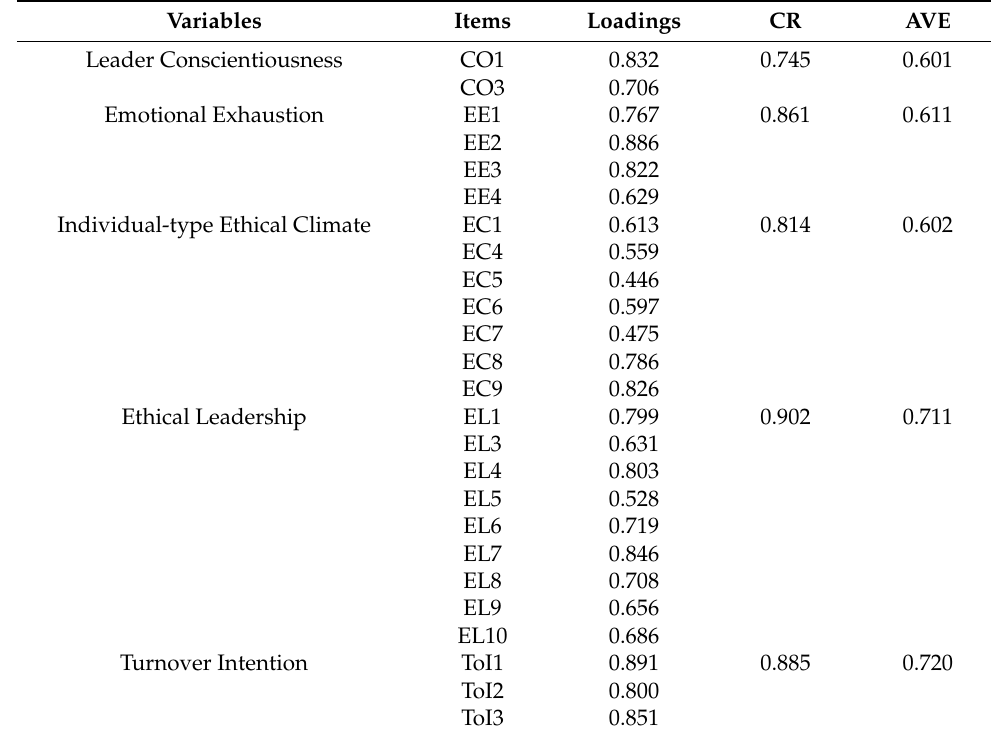
Table 3. Reliability and convergent validity of study constructs.